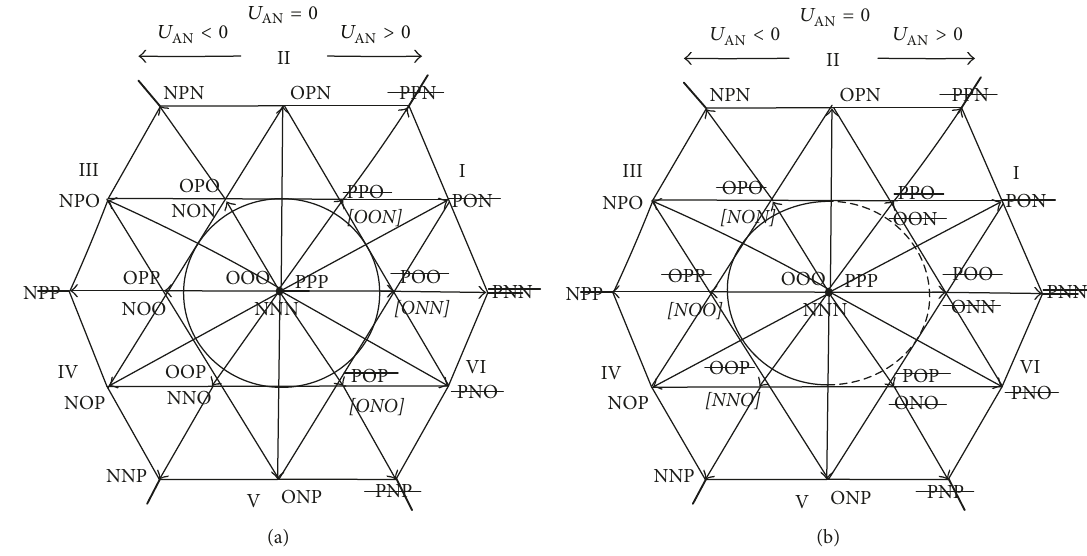
Figure 4: Voltage vector distribution under device open fault of phase A. (a) QA1 fault. (b) QA2